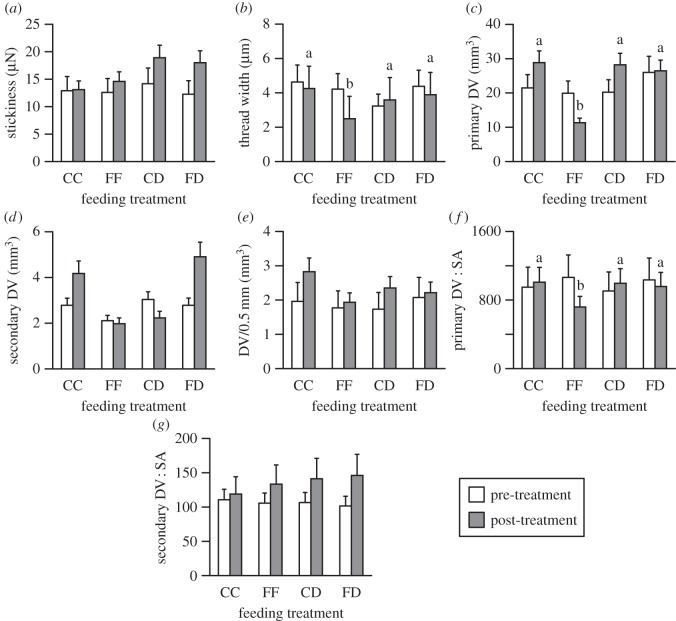
Pre-treatment (empty bars) compared with post-experiment (filled bars) values (mean±s.e.) for: (a) spiral stickiness, (b) spiral thread width, (c) primary droplet volume (DV), (d) secondary droplet volume (DV), (e) droplet volume per 0.5 mm of spiral thread (DV/0.5 mm), (f) primary droplet volume-to-surface area ratio (DV : SA), and (g) secondary droplet volume-to-surface area ratio (DV : SA) for Nephila pilipes fed live crickets (CC), live flies (FF), dead crickets with the web stimulated by live flies (CD) or dead flies with the web stimulated by live crickets (FD). Letters show the results of Fisher's least significant difference post hoc analyses (a>b>c).